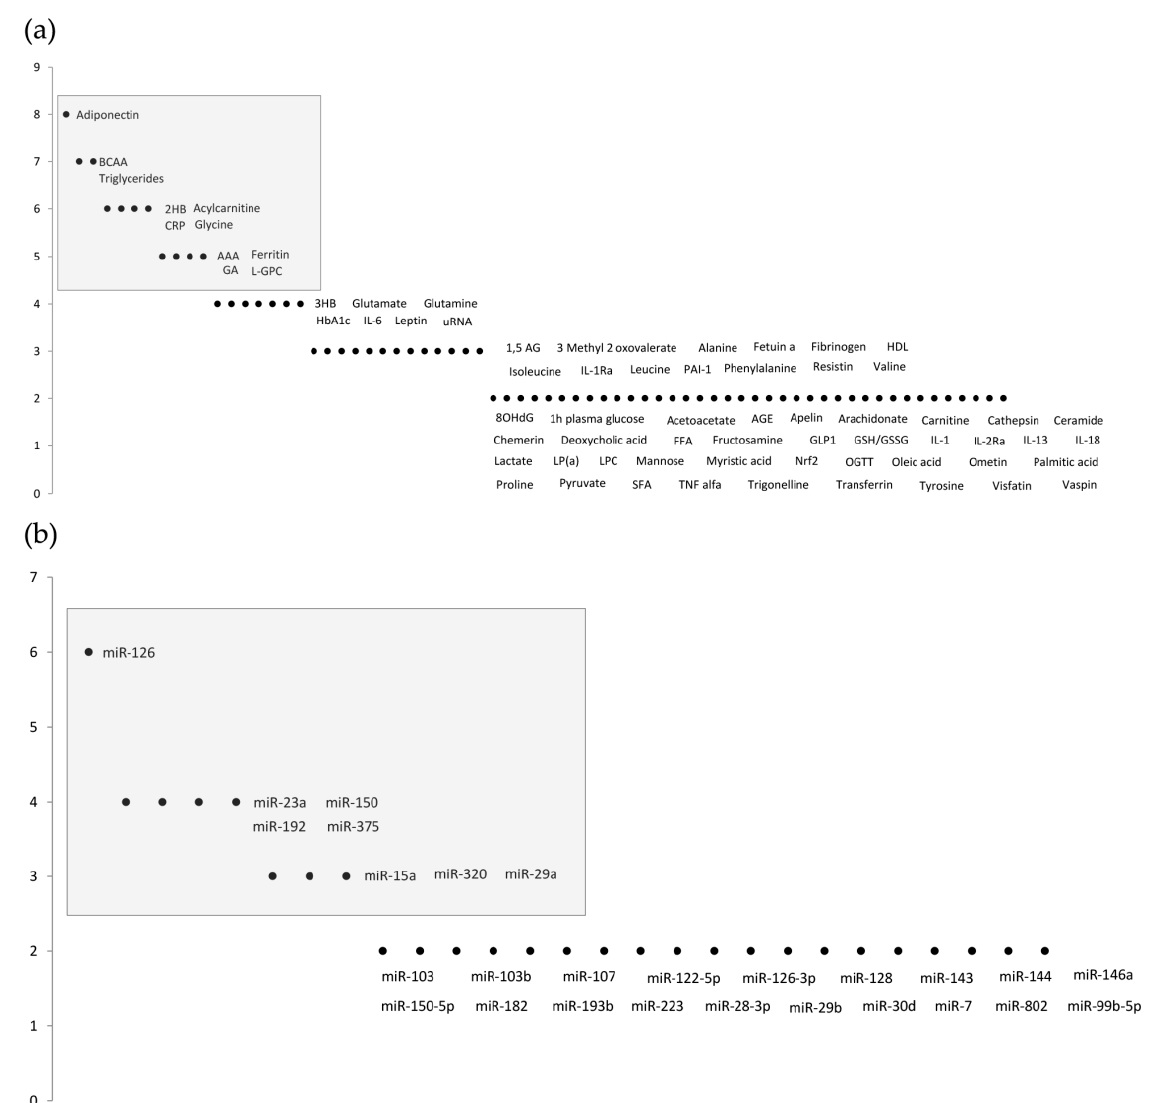
Figure 1. Number of citations regarding biomarkers associated with ( a ) metabolomics studies; ( b ) microRNA studies. The grey areas highlight the most relevant biomarkers. Biomarkers with just one reference were not included in these results.